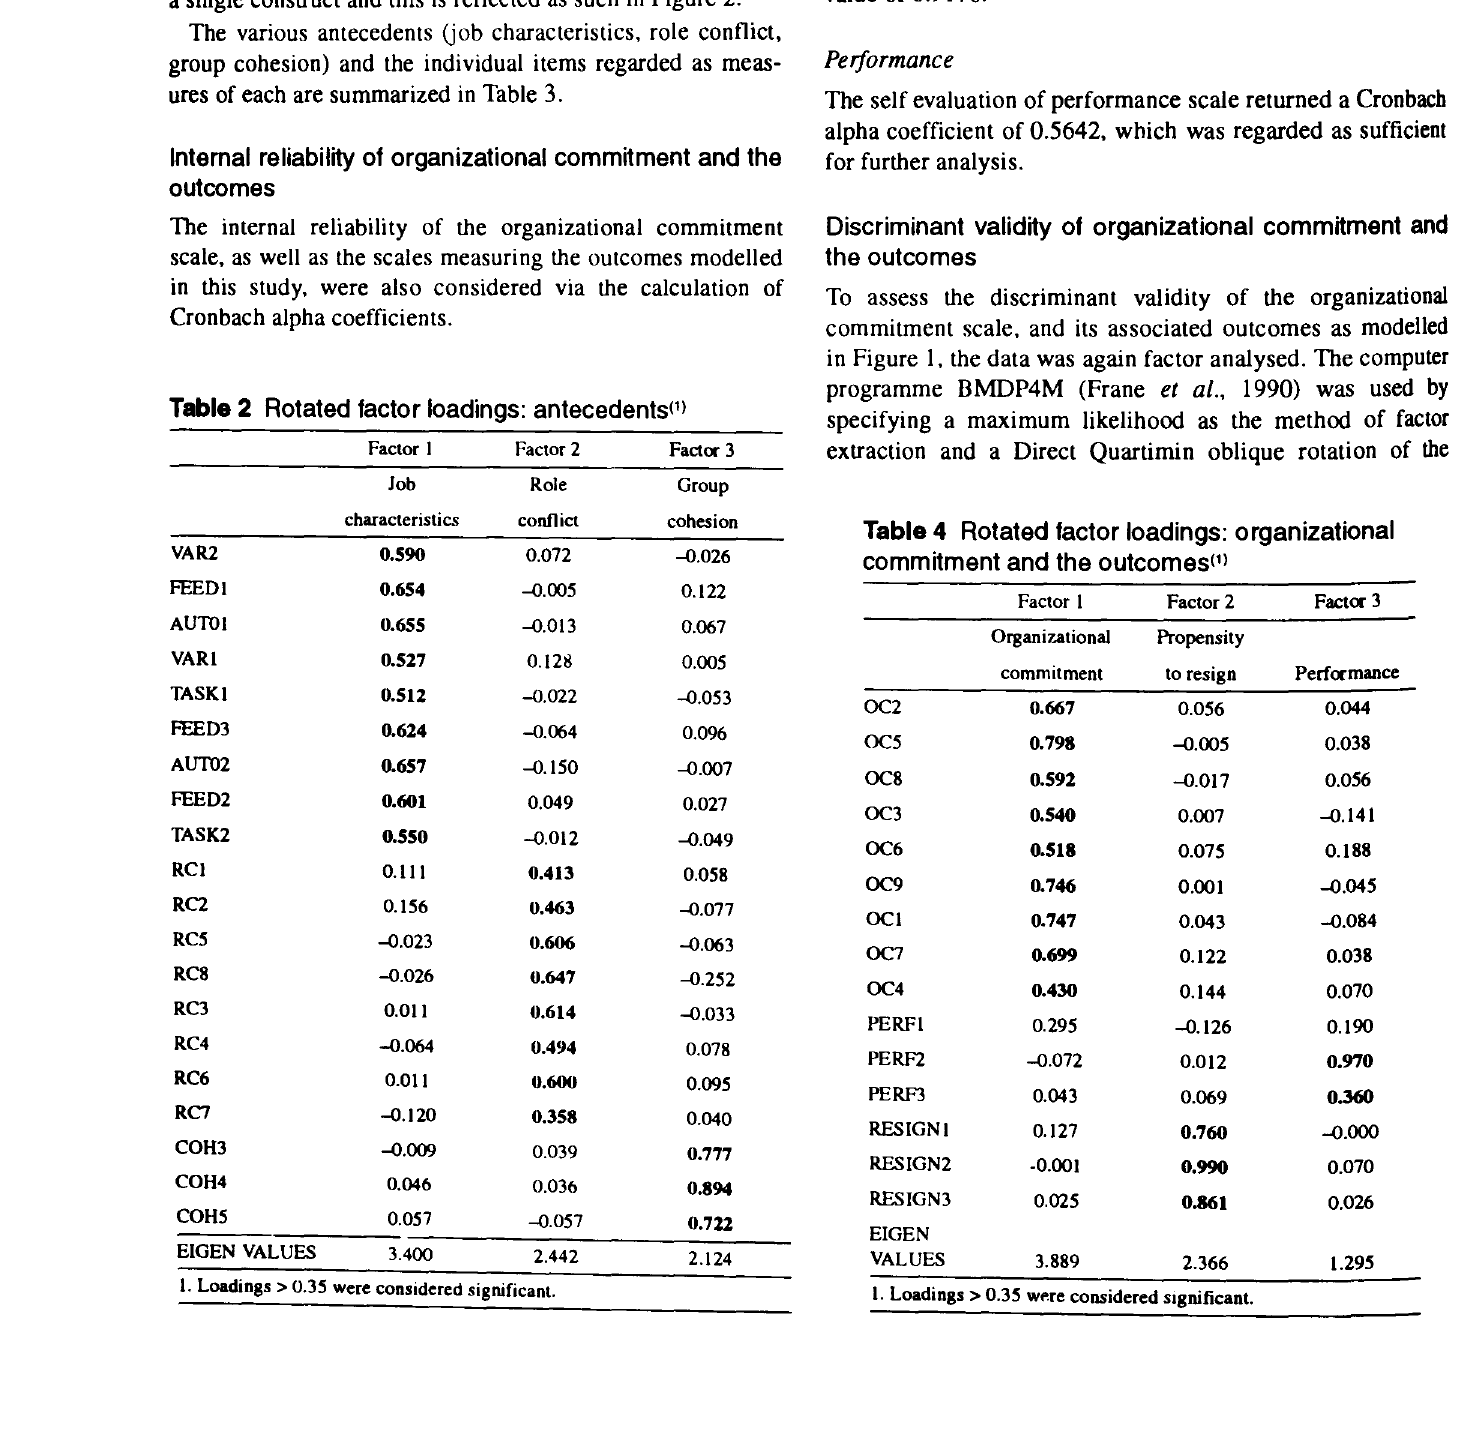
Table 4 Rotated factor loadings: